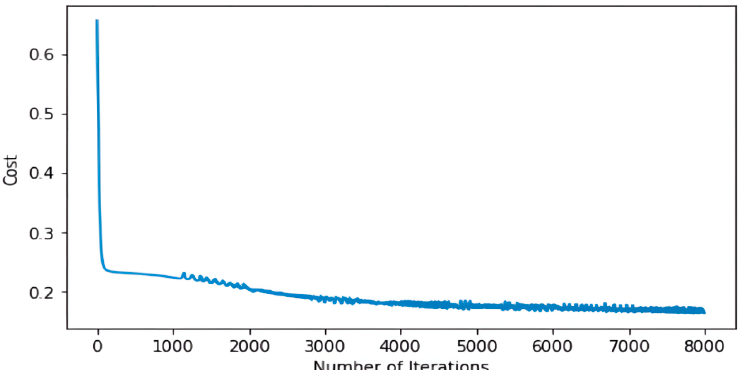
Figure 5. The abscissa represents the training iterations; the ordinate represents the total network loss. Table 4. Training results of improved YOLOv4 network for balanced category datasets. Table 3. Training results of improved YOLOv4 network for unbalanced category datasets. Number of Iterations